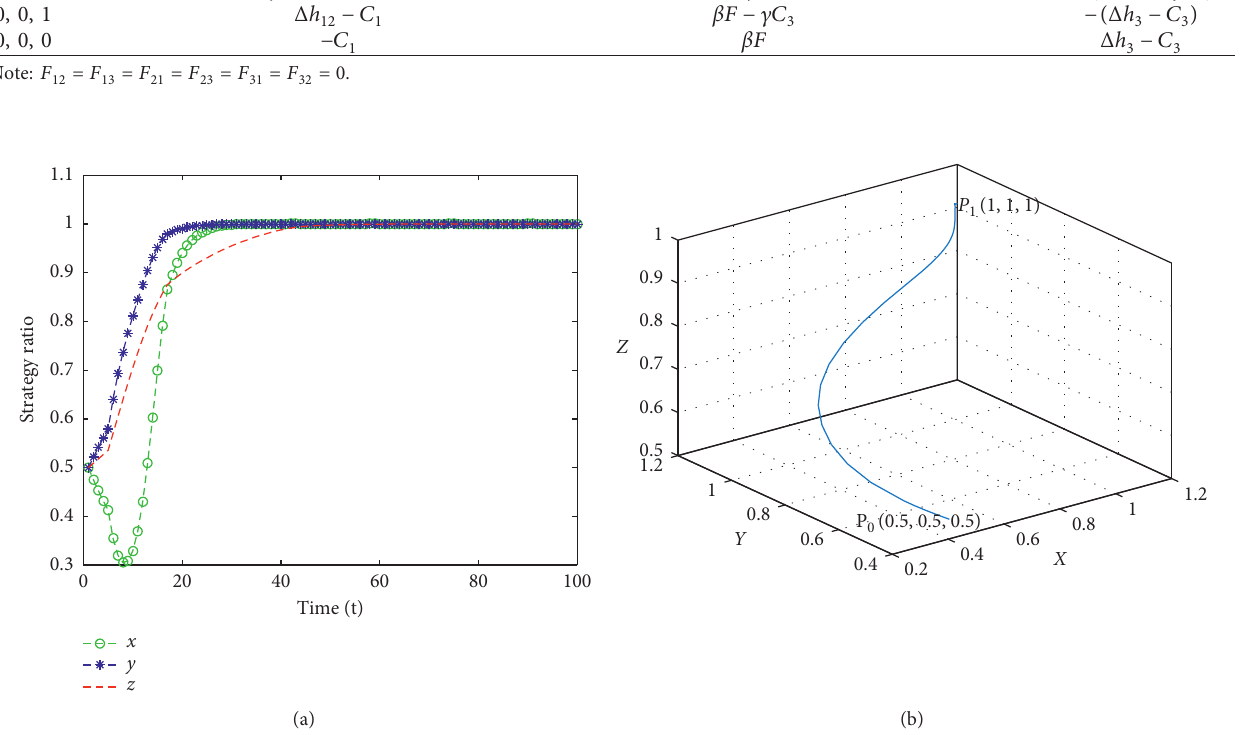
Figure 1: The dynamic evolution of the tripartite game model when x � 0 . 5 , y � 0 . 5 , and z � 0 . 5. (a) Time evolutions of x , y , and z ; (b) time evolutions of ( x , y , z